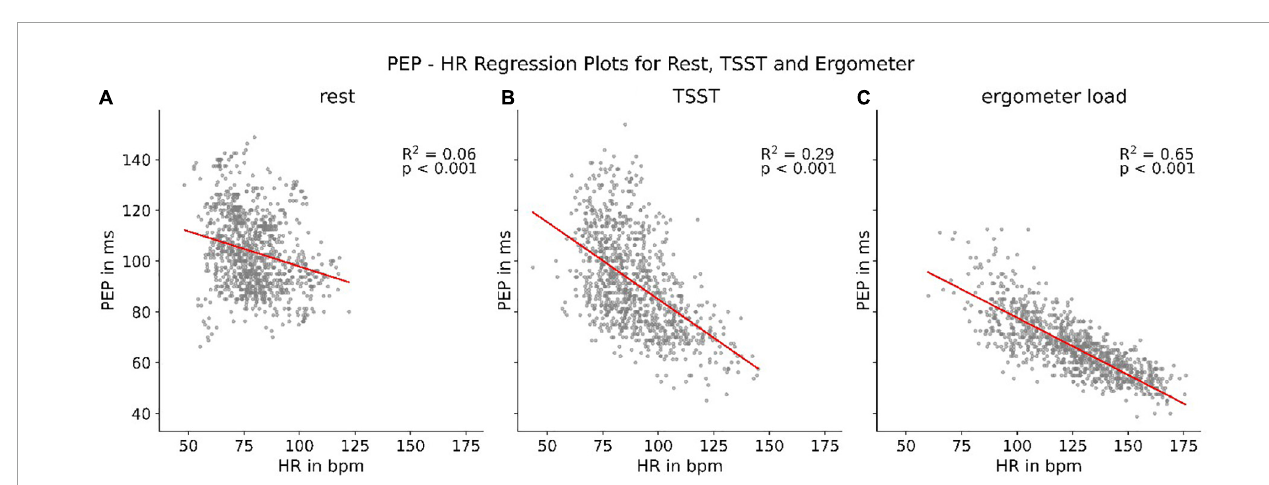
FIGURE6 Regression between heart rate (HR) and PEP at rest (A) , during TSST (B) , and treading (C) the bike